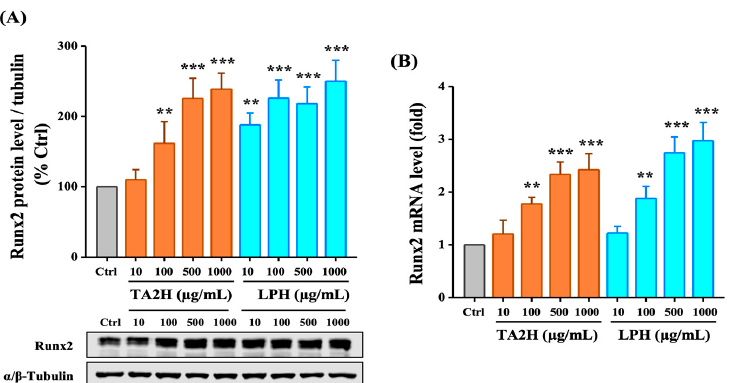
Figure 4. Effects of whey protein hydrolysates (TA2H and LPH) on Runx2 expression in preosteoblast cells. MC3T3-E1 cells were seeded on six-well plates and were treated with growth medium containing 0 (control group), 10, 100, 500, and 1000 µ g/mL of TA2H and LPH for 72 h. ( A ) The relative protein expression of Runx2 was measured by Western blotting, and α / β -tubulin was used as the loading control. ( B ) The mRNA expression of Runx2 was determined by RT-PCR assay. Data are represented as the mean ± SEM, n = 3. **, and *** indicated p < 0.01 and p < 0.001, as compared to the control